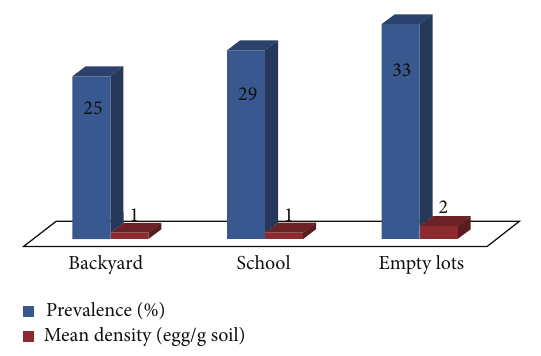
Figure 2: Prevalence and mean density of Toxocara eggs in soils fromvarioussamplingsitesofselectedtownsinLaguna,Philippines.